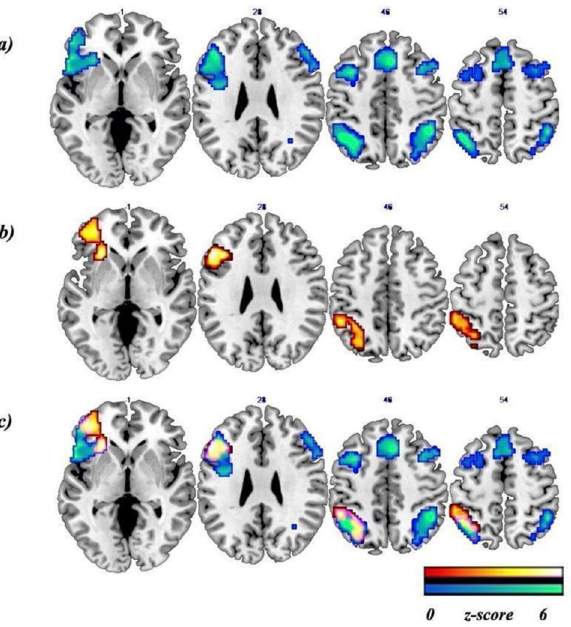
Figure 1. Main effects of the fMRI RE-task. Note Results of: ( a ) whole brain one-sample t-test in RE group (blue-green bar); ( b ) whole brain one-sample t-test in non RE group (red–orange bar); ( c ) common regions between RE and non-RE groups (violet-pink). Results were p < .05 FWE cluster-corrected using a threshold of p < .005 at the uncorrected voxel level and a cluster size of k = 199 voxels and k = 163 voxels, respectively. Coordinates are in the MNI space. The left/right of the image corresponds to the left/right brain hemisphere.